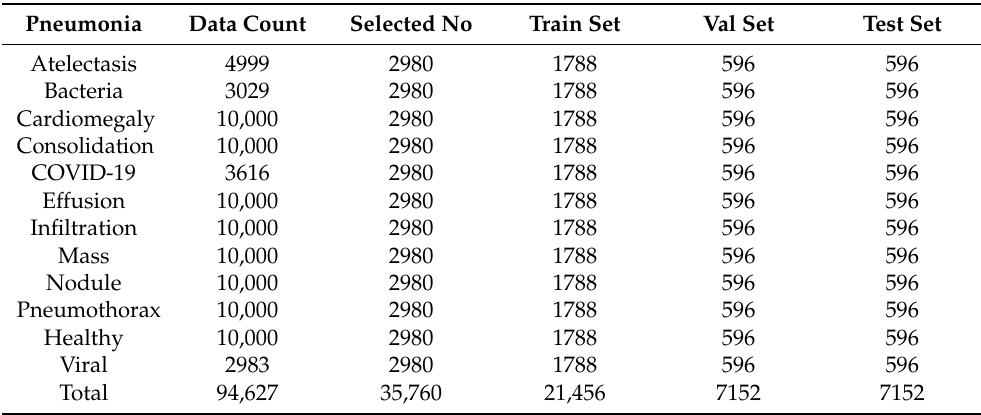
Table 1. Description of the chest X-ray dataset showing different categories of pneumonia illnesses and the distribution of images per category, as well as the number of selected images per category.